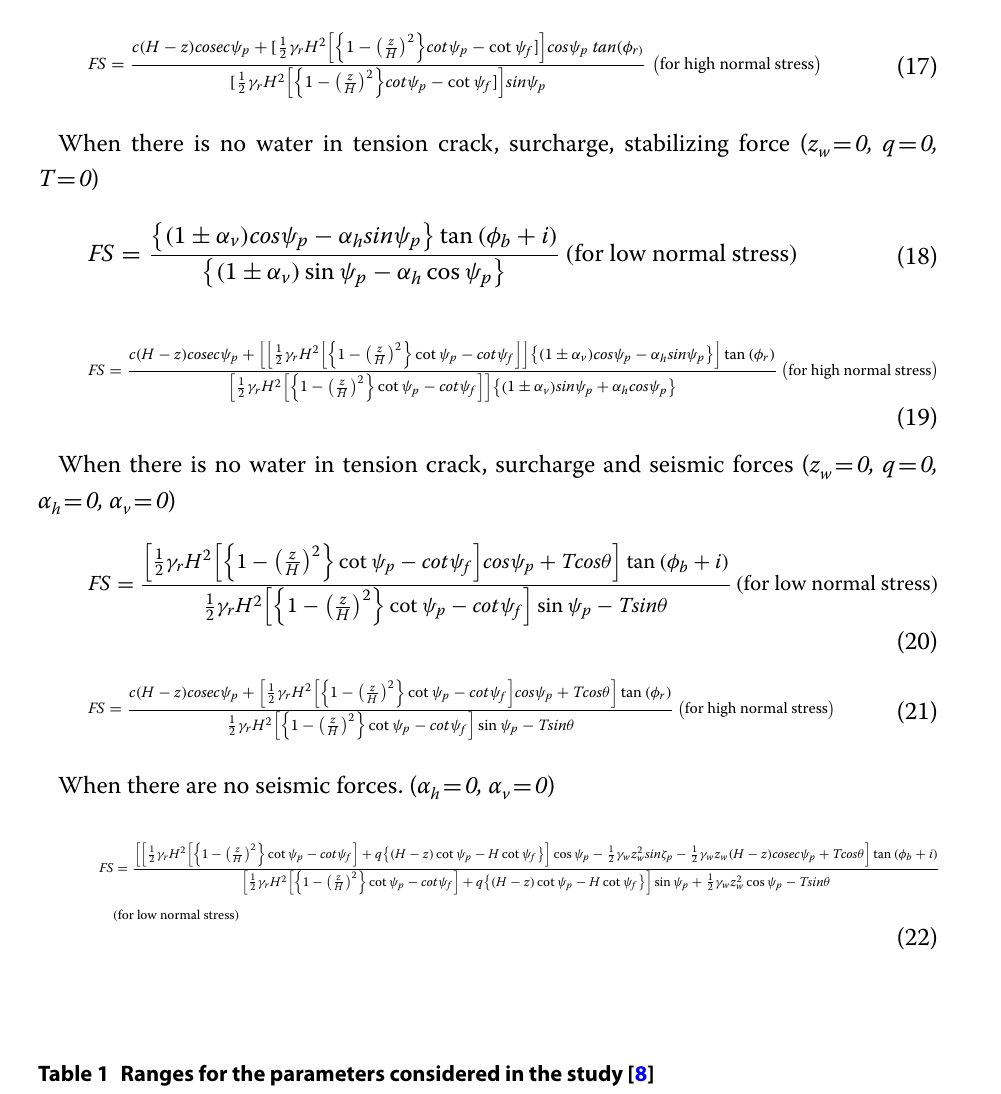
Table 1 Ranges for the parameters considered in the study [8] Sl.